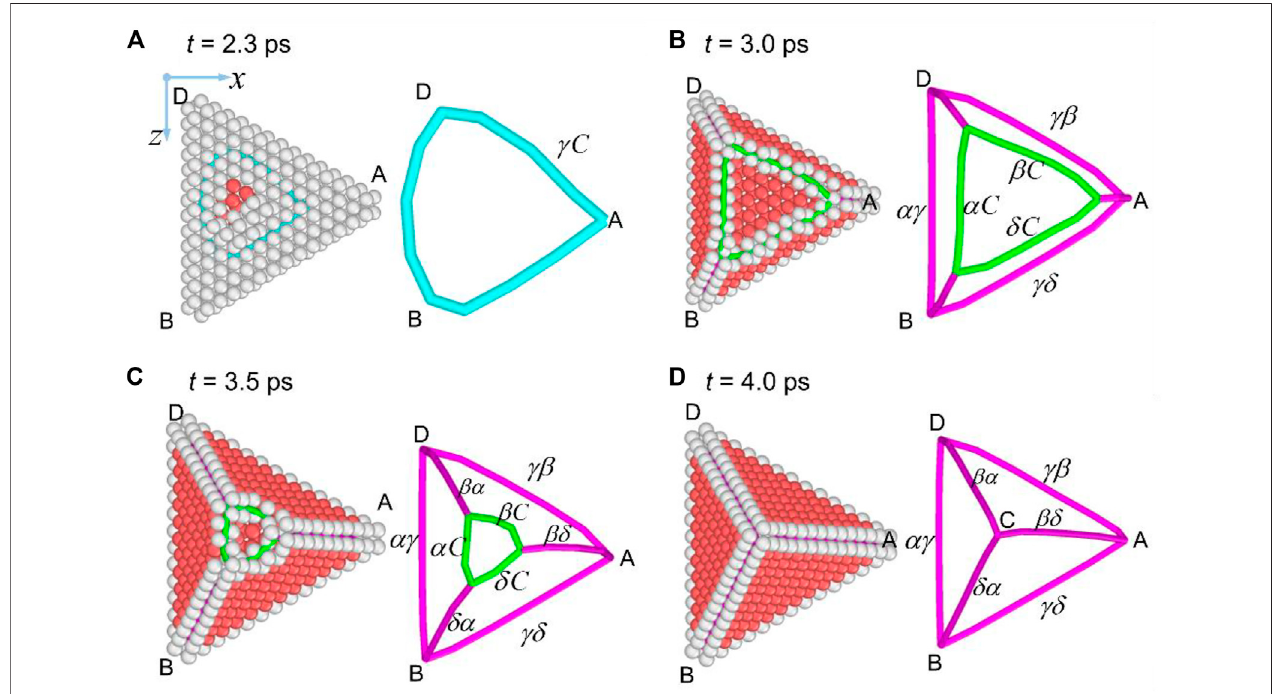
FIGURE 2 | Formation of SFT in CoCrFeNiMn. (A) Frank dislocation loop γ C , (B) dissociation of Frank dislocations, (C) glide of Shockley partial dislocation, (D) perfect SFT, with red atoms representing SF.